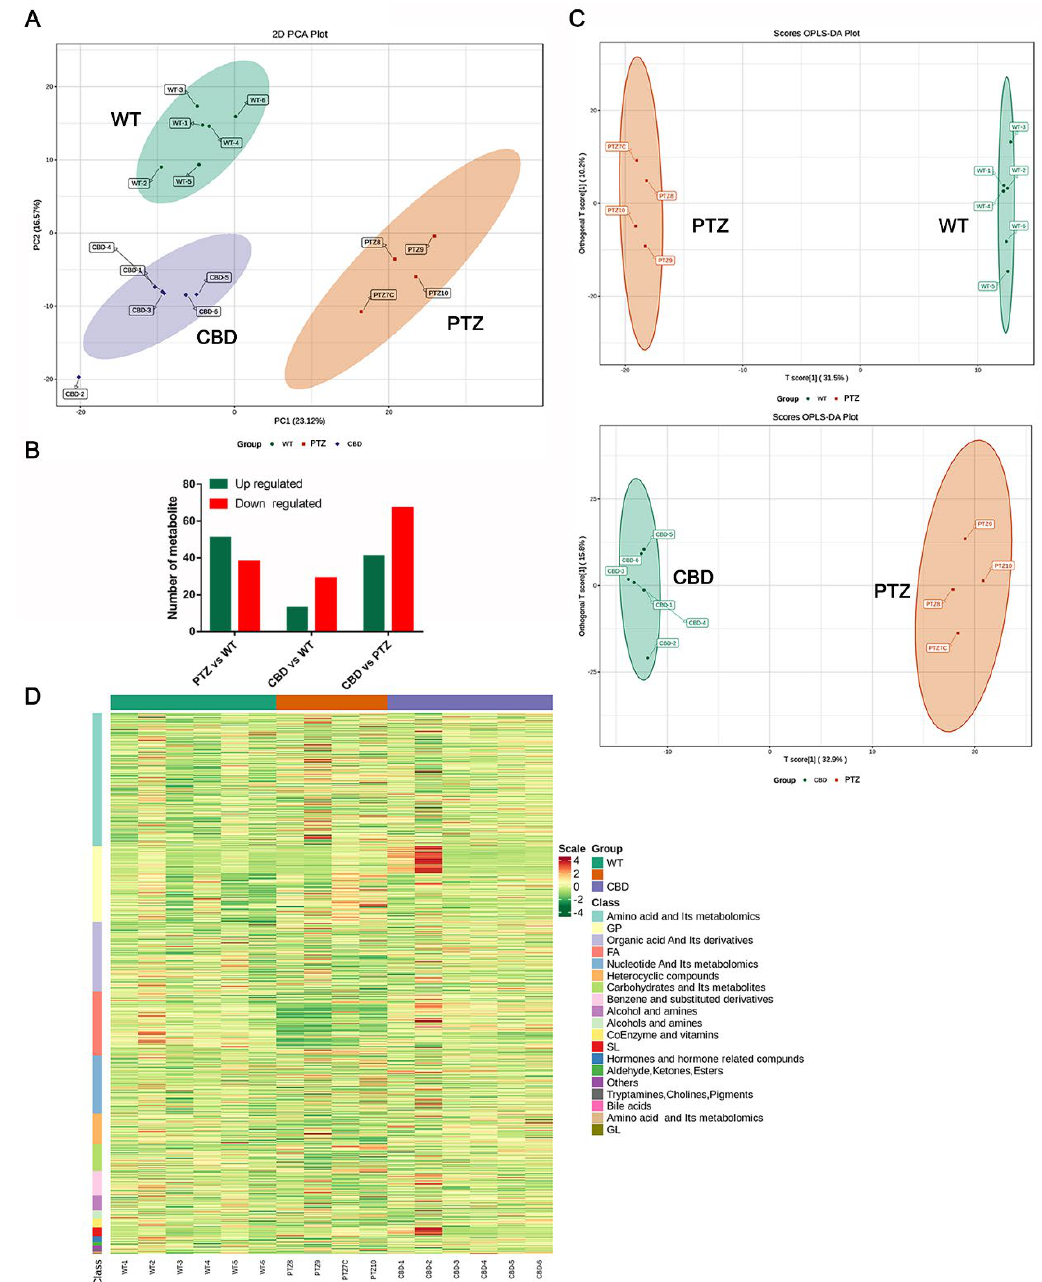
Figure 5. Metabolite profiling analysis of the WT, PTZ , and CBD group. ( A ) The PCA score scatter plot of the positive ionization mode. ( B ) The number of up - regulated and down - regulated metabo- lites between the groups. ( C ) The result of the Partial Least Squares - Discriminant Analysis (PLS − DA). The OPLS - DA score scatter plots were compared between the groups. ( D ) The clustering heat map analysis of all samples. n = 6 in the PTZ group, n = 4 in the CBD group. To better understand the changes of substances in potentially important metabolic pathways in different groups, we analyzed the KEGG metabolic pathway that contains at least five differential metabolites and performed cluster analysis on the relative content of all differential metabolites in these pathways. As illustrated in Figure 6A , D- Glucarate, Deoxyguanosine, Hippuric Acid, L - Dopa Pyridoxal, Mucic Acid, and S - Ribosyl - L - homo- cysteine were significantly elevated in the hippocampus of mice with PTZ kindling, and CBD exposure can reverse this increase (Figure 6B).